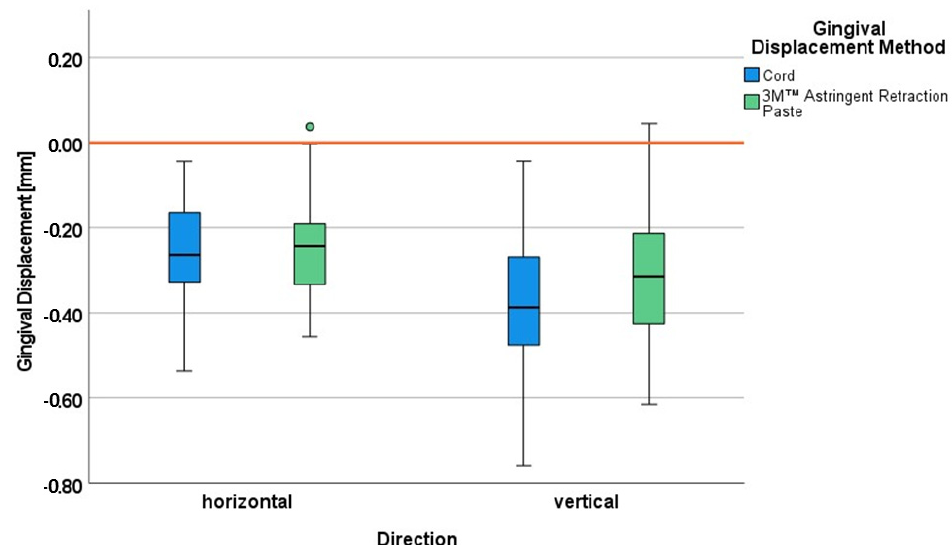
Figure 7. Gingival displacement in horizontal and vertical direction for the cord method and the 3M™ Astringent Retraction Paste; negative value: gain in sulcus width (horizontal)/depth (vertical) after gingival displacement; the circle represents an outlier value (more than 1.5 times the box width away).